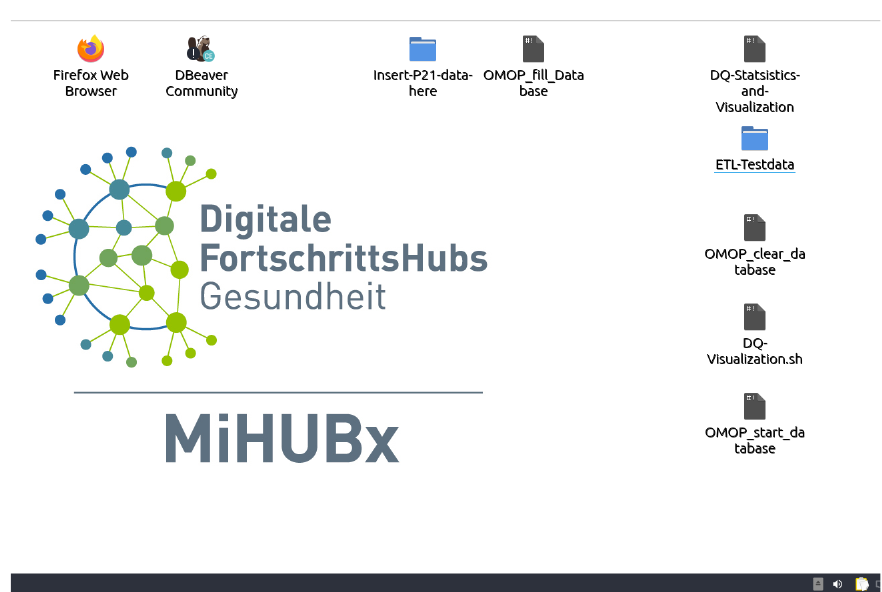
Figure 2. Screenshot of the virtual machine. Black icons represent the included shell scripts.